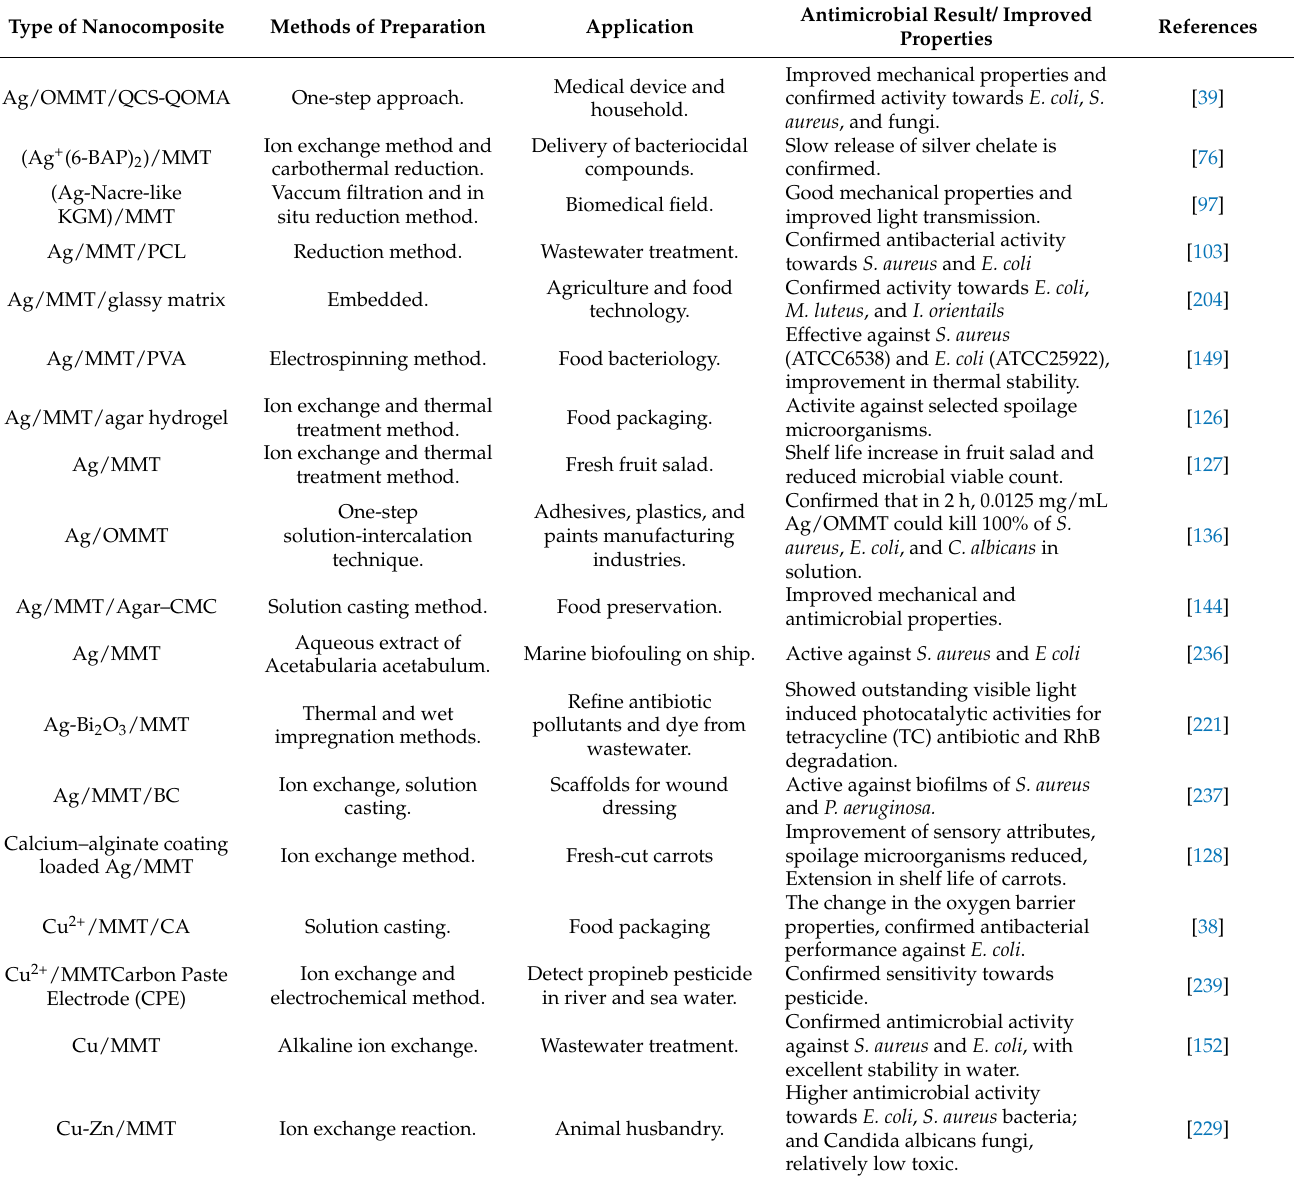
Table 1. Summary of literature of nanocomposite prepared by several methods for potential applica- tion in different